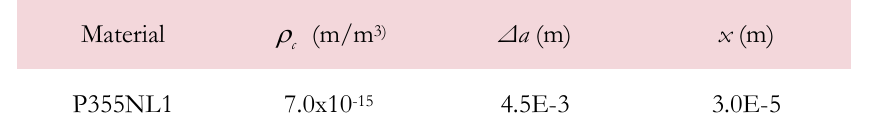
Table 4: Fatigue crack growth rate constants from Eq.